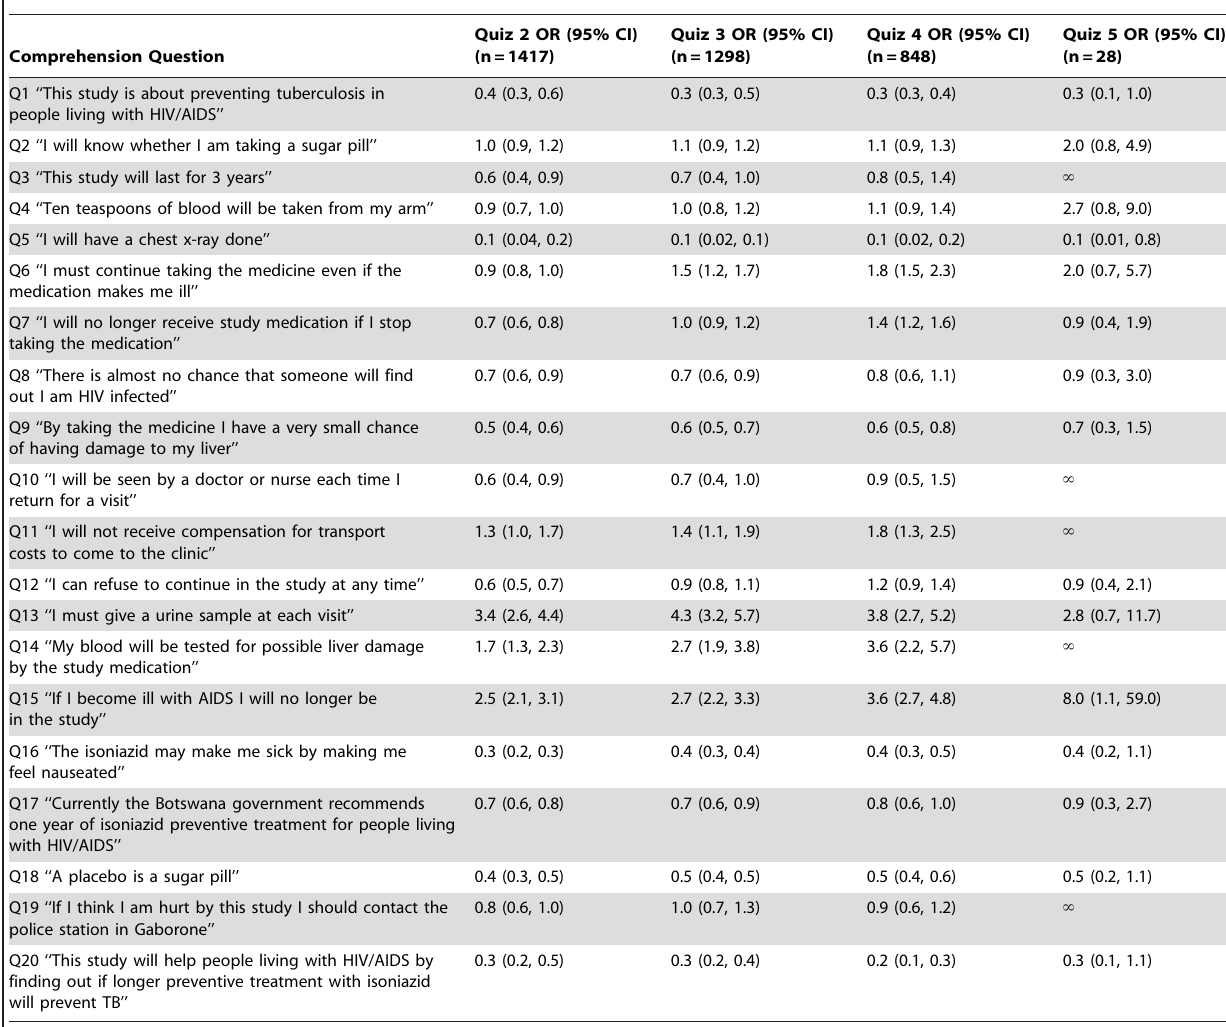
Table 8. Odds of answering comprehension quiz questions 1–20 correctly at Quizzes 2–5 compared to enrollment quiz.